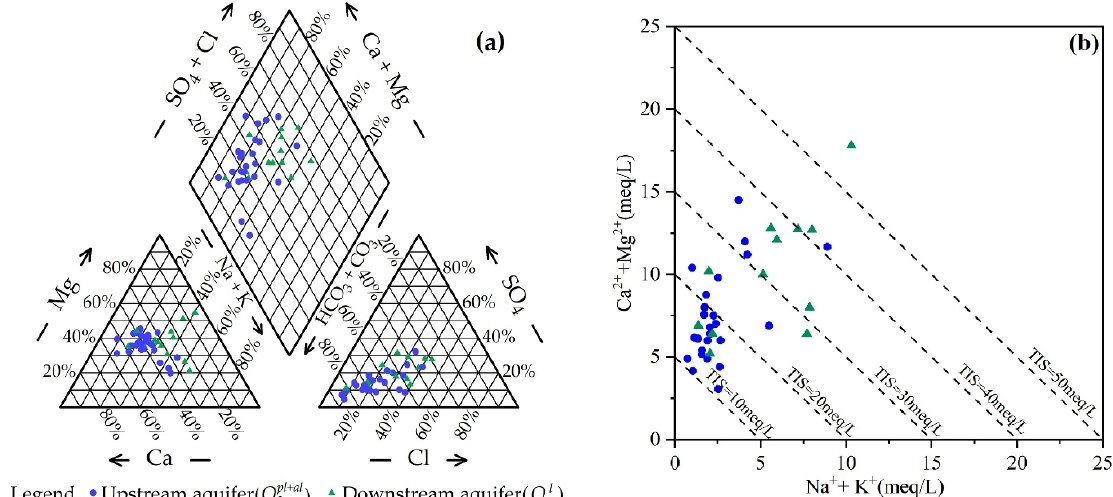
Figure 4. Piper diagram of groundwater ( a ) and correlation plot of (Na + + K + ) vs. (Ca 2+ + Mg 2+ ), also showing TIS salinity diagram for reference ( b ).